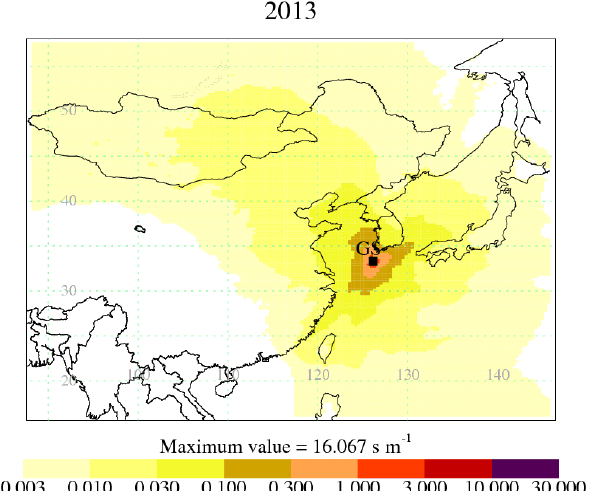
Figure 1. An aggregation of the dilution matrices from 2013, gen- erated using NAME output (see Sect. 2.2), illustrating the relative sensitivity of measurements at GSN to emissions in the